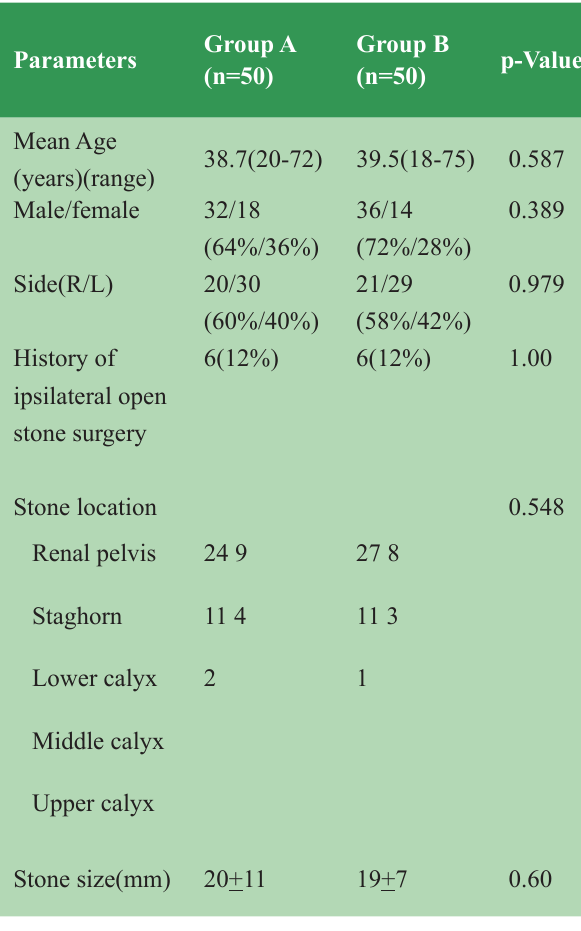
Table 1. Preoperative variables of